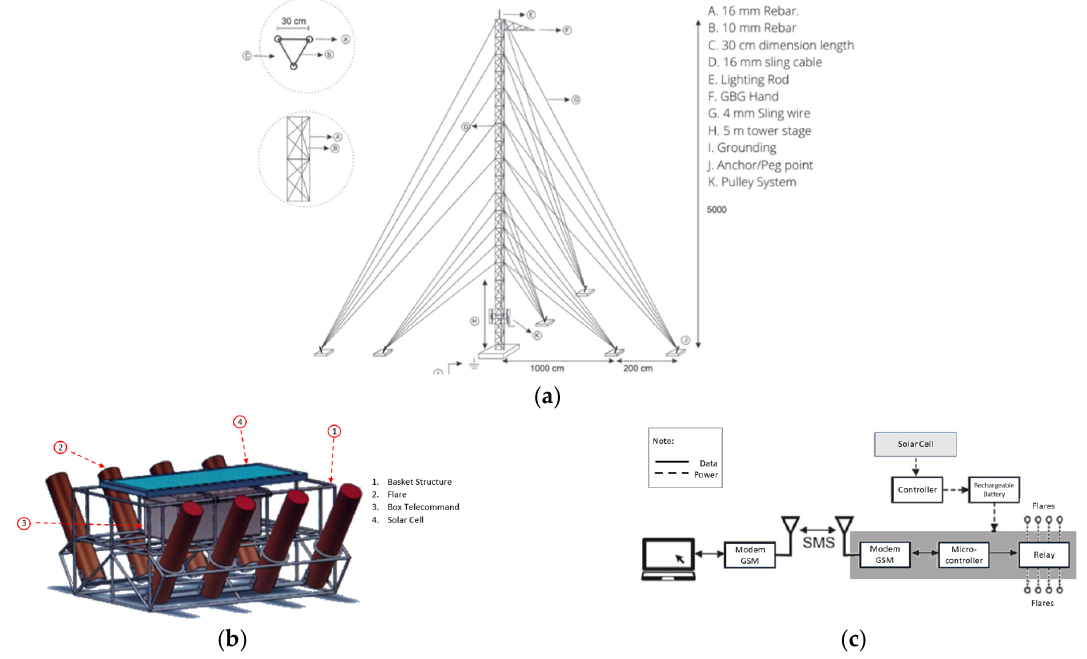
Figure 1. ( a ) GBG technical design; ( b ) flare bucket; ( c ) electronic ignition schematic ignition (bottom right).